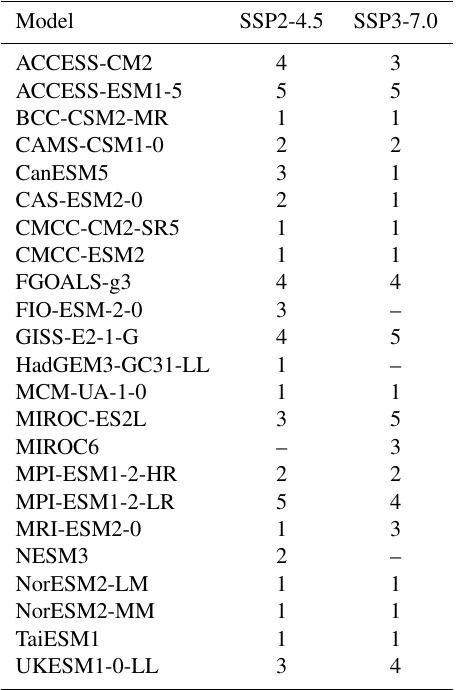
Table 2. The number of emulated trajectories produced to assess the performance of STITCHES in recreating intermediate scenar- ios (SSP2-4.5 and SSP3-7.0) from the two “bracketing” scenarios (SSP1-2.6 and